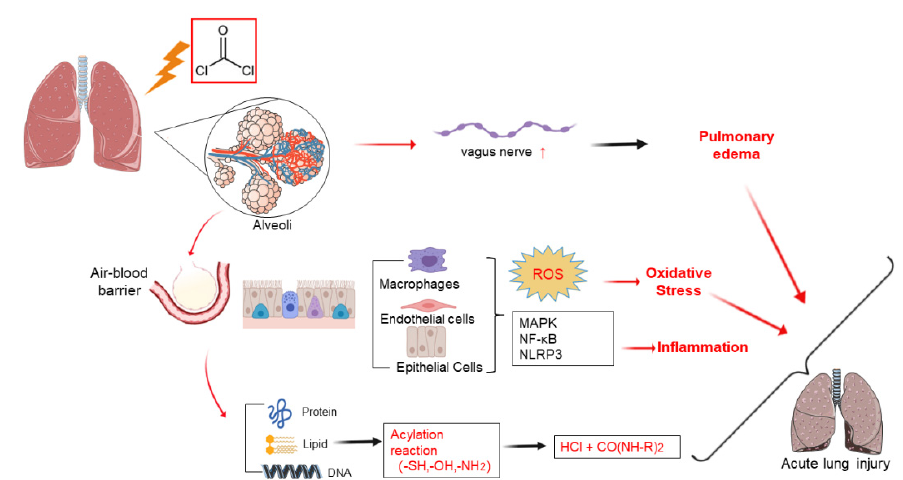
Figure 1. The mechanisms of phosgene-induced acute lung injury.